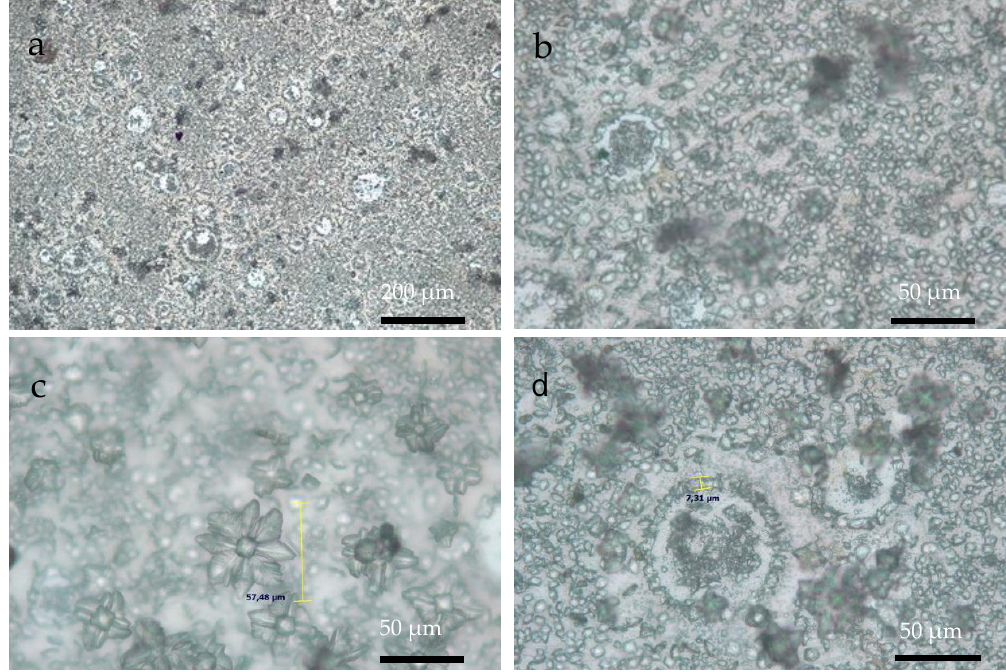
Figure 7. OM images of CaOx crystals obtained on ITO substrate modified with R-chitosan fibers at ( a ) 10× and ( b – d ) 40× magnifications.